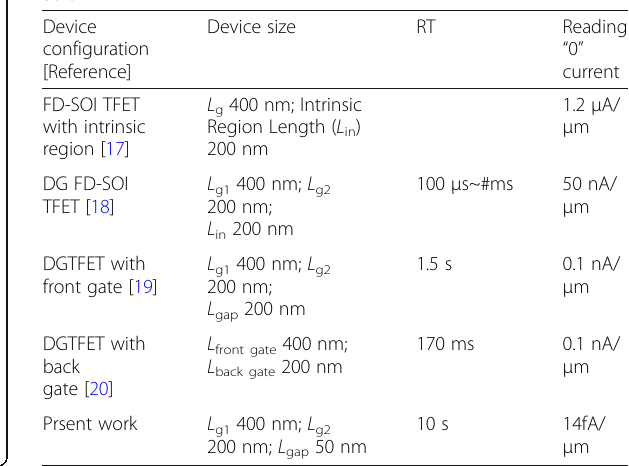
, L , and L . In Table 4, the g1 g2 gap , L , g1 gap Table 3 Performance properties of various TFET DRAM utilized as